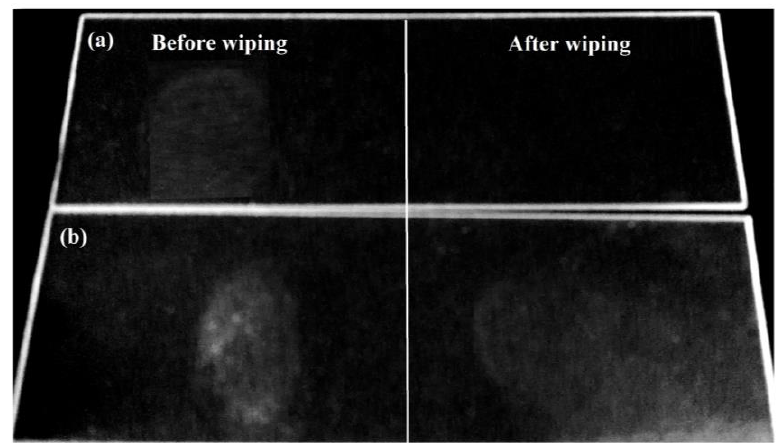
Figure 13. Fingerprint test: ( a ) coating with FSi@SiO 2 treating solution; ( b ) blank.